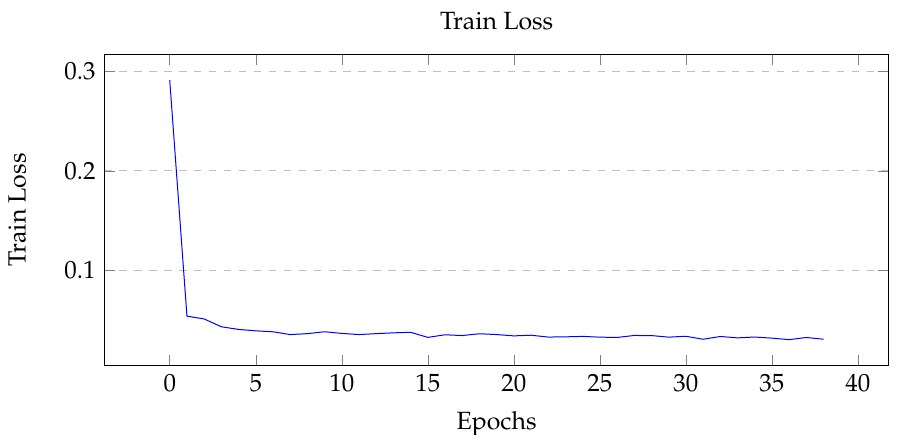
Figure 7. Graph of training loss over each epoch. Initial large decrease for the first ten epochs followed by a gradual decrease.